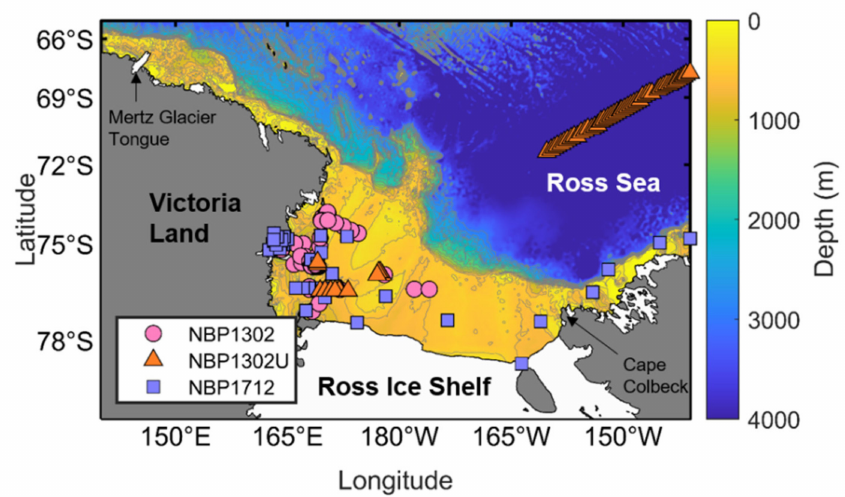
Figure 1. Map of the Ross Sea, including bathymetry (colored) and in situ data location from the three cruises; NBP1302 (light red circles), NBP1302U (orange triangles) and NBP1712 (light blue squares). The bathymetry data were obtained from the GEBCO with 1-arc resolution. Gray contour lines indicate the depth from 400 to 1200 m with a 100-m depth interval.